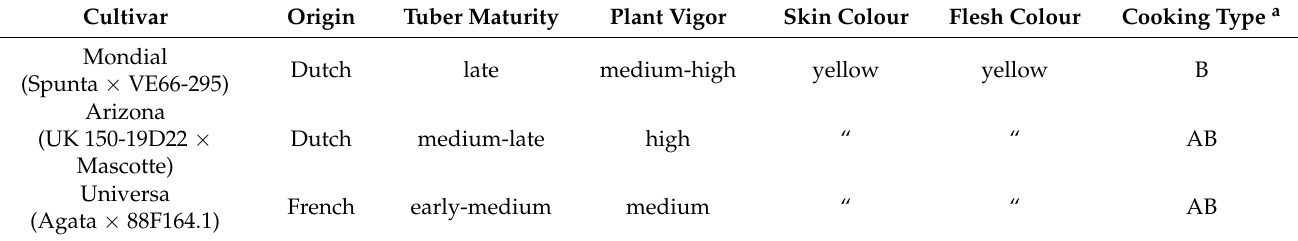
Table 3. Tuber seed origin, main biological, physiological, and tuber sensory traits of the studied potato cultivars.